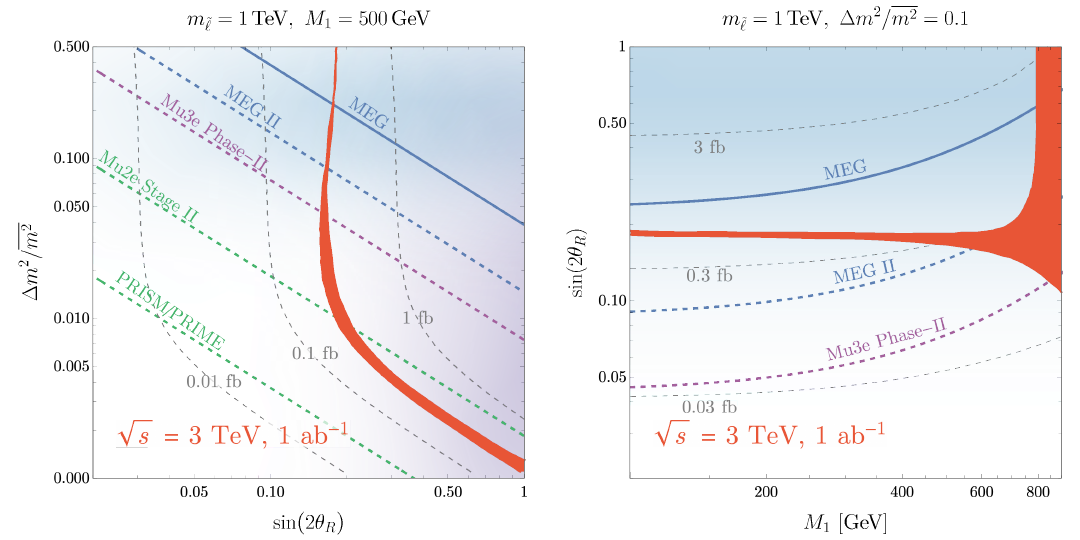
Figure 4. 5 σ discovery reach of the lepton-flavor violating MSSM by a 3 TeV muon collider with 1 ab − 1 of data in the ∆ m 2 /m 2 vs sin 2 θ R plane and the sin 2 θ R vs M 1 plane (red band). The width of the collider reach band shows the uncertainty due to inexact slepton and neutralino mass measurements. The gray contours are cross sections of the signal process. Both plots assume a mean slepton mass of 1 TeV. In the left plot we fix the neutralino mass M 1 = 500 GeV, while in the right figure ∆ m 2 /m 2 is fixed to 0.1. The current (solid) and expected (dashed) limits from low-energy lepton flavor violation experiments are indicated by the blue, purple and green lines. The purple and blue shaded lightly shaded regions indicate parameters preferred in Gauge- Mediated Supersymmetry Breaking scenarios and flavor-dependent mediator scenarios, respectively (as described in appendix